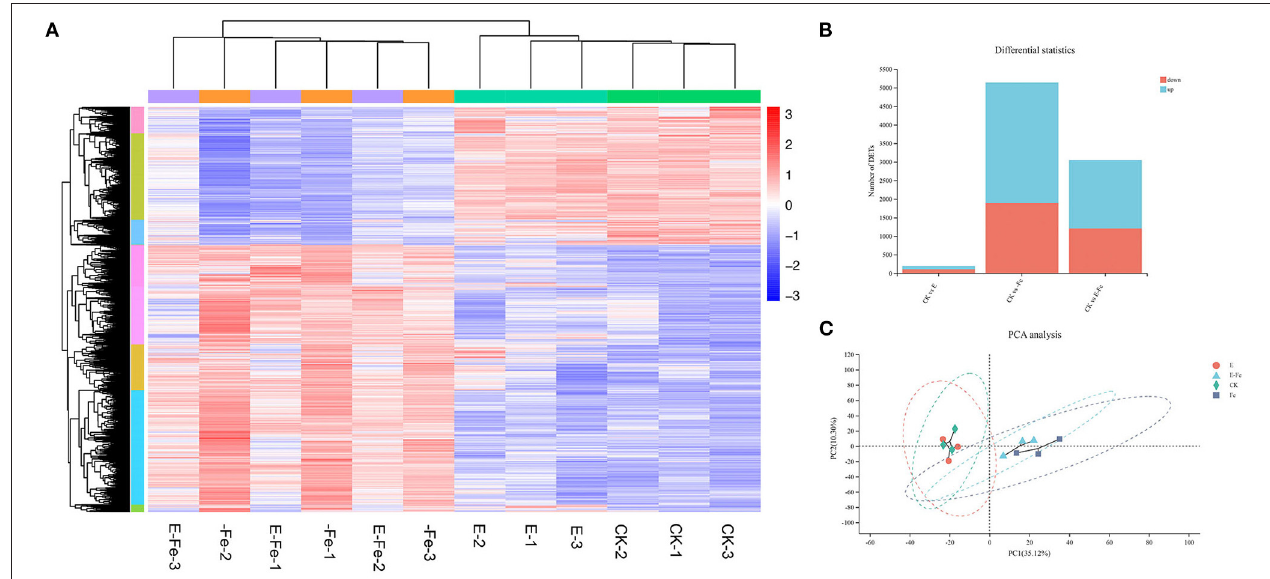
FIGURE 8 | Global analysis of peanut gene expression during early interactions with P. liquidambaris . RNA was extracted from peanut root at 7 days after growth on solution with or without P. liquidambaris cocultivation, and then RNA-sequencing was performed. (A) Differentially expressed genes were hierarchically clustered according to potentially similar functions. (B) The Venn diagram depicting the common DEGs. (C) : PCoA analysis. E = P. liquidambaris inoculation. -Fe = 2 µ mol FeEDTA in Hogland nutrition. CK = 100 µ mol FeEDTA in Hogland nutrition. Red color represents the high expression of the gene, whereas blue color represents low